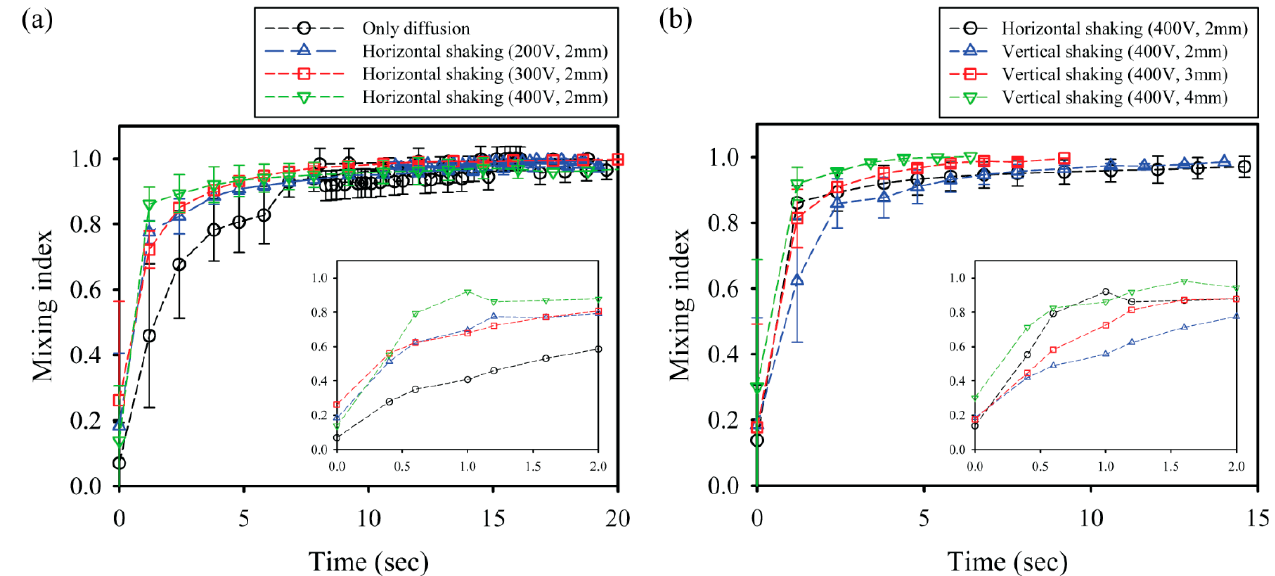
Figure 6. ( a ) Temporal variation in the mixing index as a function of applied voltage in the case of horizontal shaking via horizontal reciprocating motion. ( b ) Temporal variation in the mixing index as a function of electrode distance in the case of vertical shaking via vertical reciprocating motion. The insets of the graphs exhibit temporal variation in the mixing index at the early stage (within nearly 2 s). The graph insets show temporal variation in the mixing index at an early stage (within nearly 2